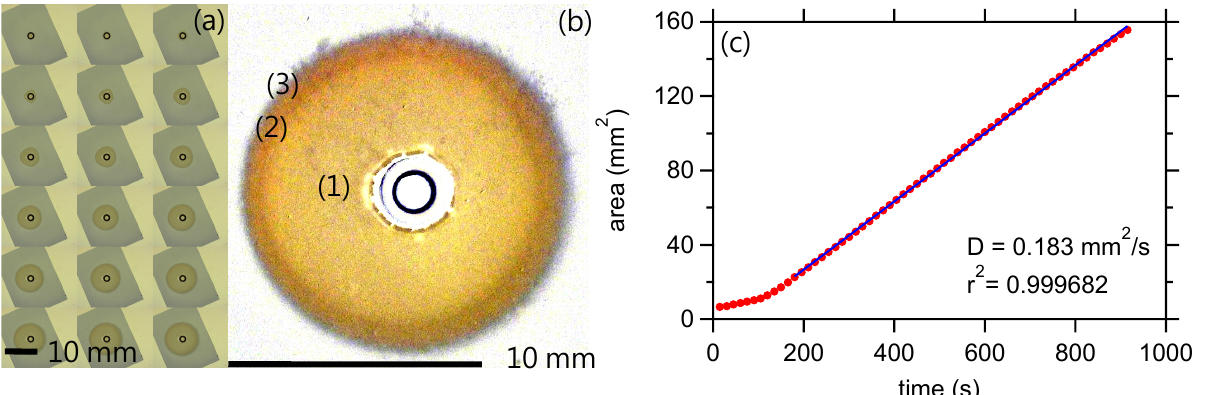
Figure 2. The growth of the degradation spot. Experimental conditions: silver thickness is approxi- mately 17 nm (50 s deposition). HCl concentration equals 0.5 wt%. ( a ) Images taken at an interval of 45 s. ( b ) Difference between the last image and first image. The spot consists of three different concentric rings: a large central ring (1), followed by a less broad ring (2), and a final ring which is at the rim of the degradation spot (3). ( c ) The area of the degradation spot as function of time. The blue line is a linear fit to the data. The slope of the line is D which equals in this case 0.183 mm 2